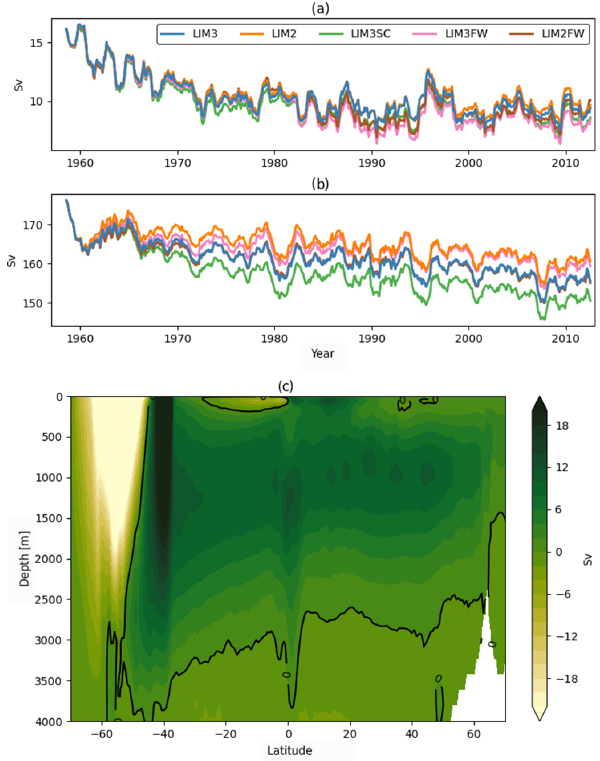
Figure 10. (a) Time series of the Atlantic Meridional Overturning Circulation (AMOC) in Sverdrups (Sv=10 6 m 3 s − 1 ) for NEMO- LIM3 simulation (blue line), NEMO-LIM2 simulation (orange line), NEMO-LIM3SC simulation (green line), NEMO-LIM3FW simulation (magenta line) and NEMO-LIM2FW simulation (brown line) integrated zonally across the Atlantic along the 50–53 ◦ N lati- tudinal band. In (b) the corresponding volume transport time series through the Drake Passage are shown. Time series in (a, b) repre- sent 12-month-running means. In (c) , the Atlantic meridional tran- sect of MOC (in Sv) for the NEMO-LIM3 simulation averaged over 2003–2012 as a function of depth and latitude is